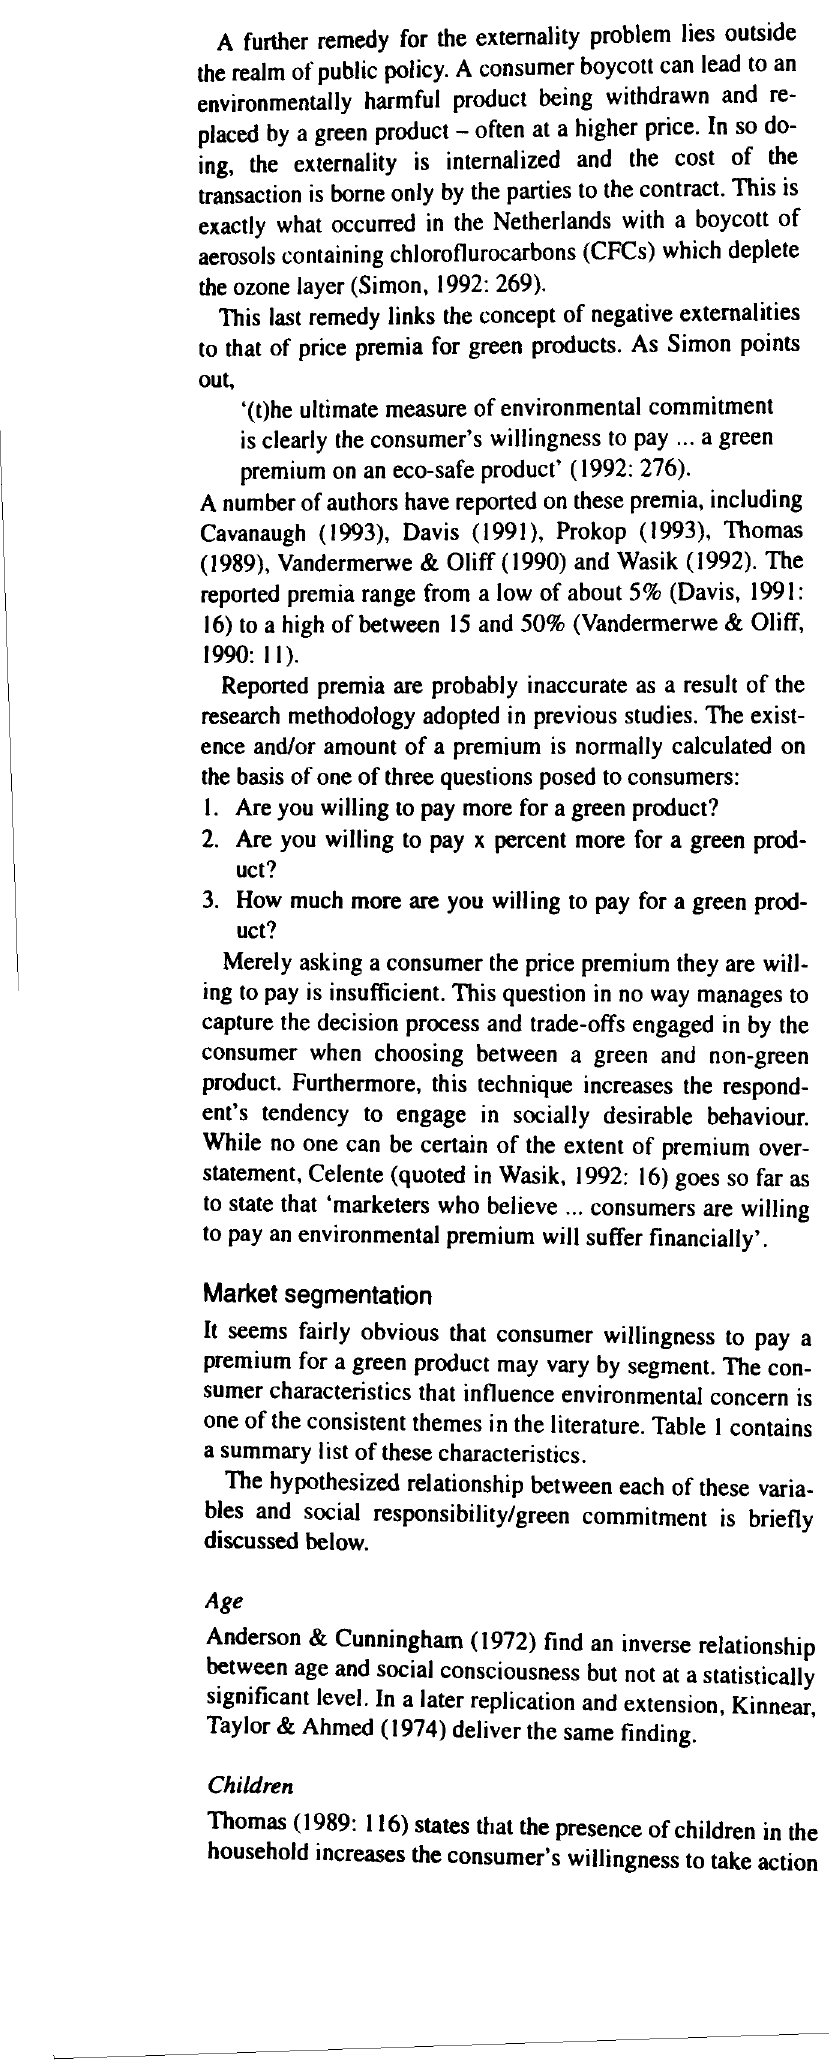
Table 1 List of variables impacting upon social responsibility or green